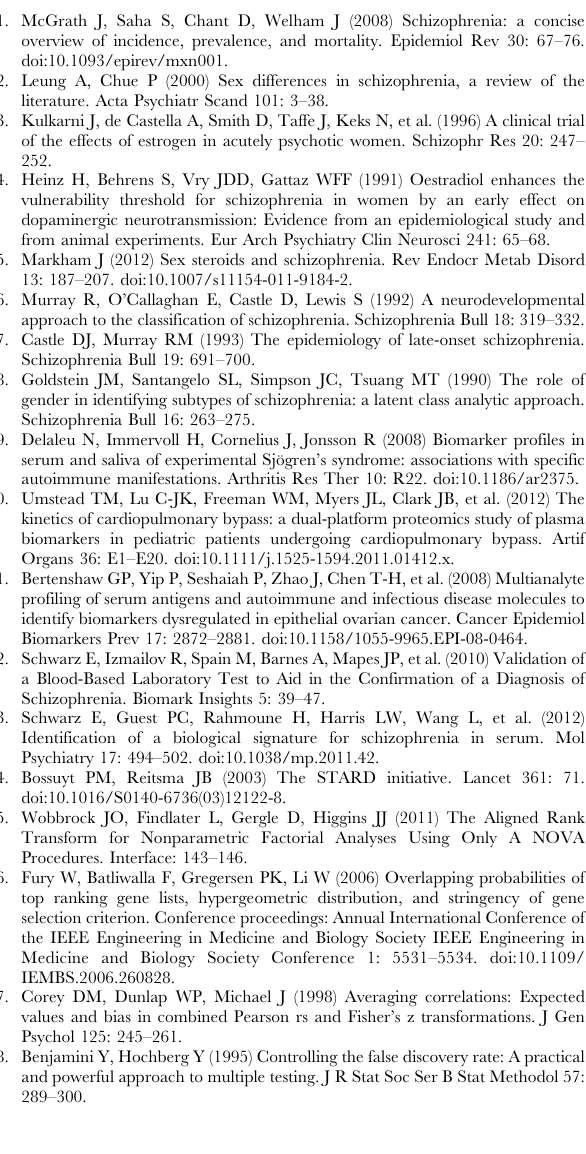
cohorts. Table S5. Summary of analyte levels with significant diagnosis-sex interactions in major depressive disorder (MDD). Table S6. Summary of analyte levels with significant diagnosis-sex interactions in bipolar disorder